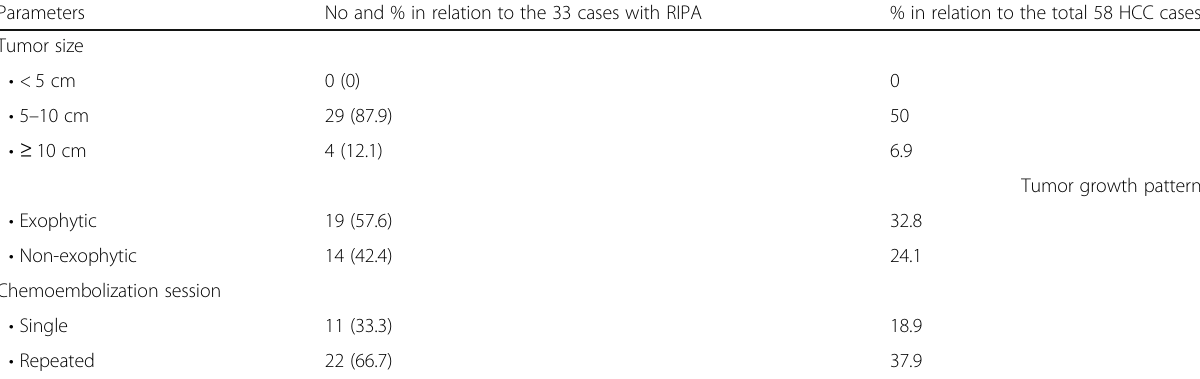
Table 3 Prevalence of Extrahepatic RIPA feeder according to tumor characteristics and chemoembolization session Parameters